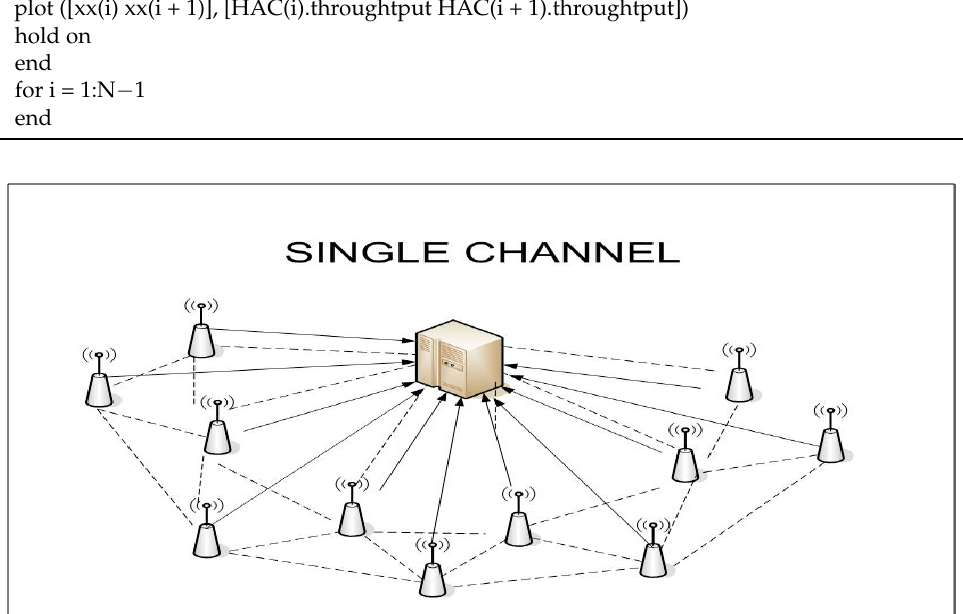
Figure 6. Single channel